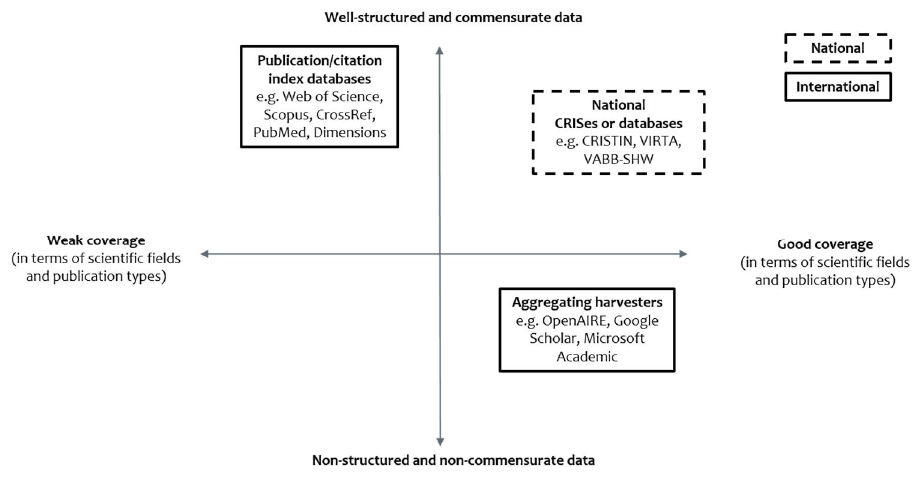
Fig. 1 . Different types of publication